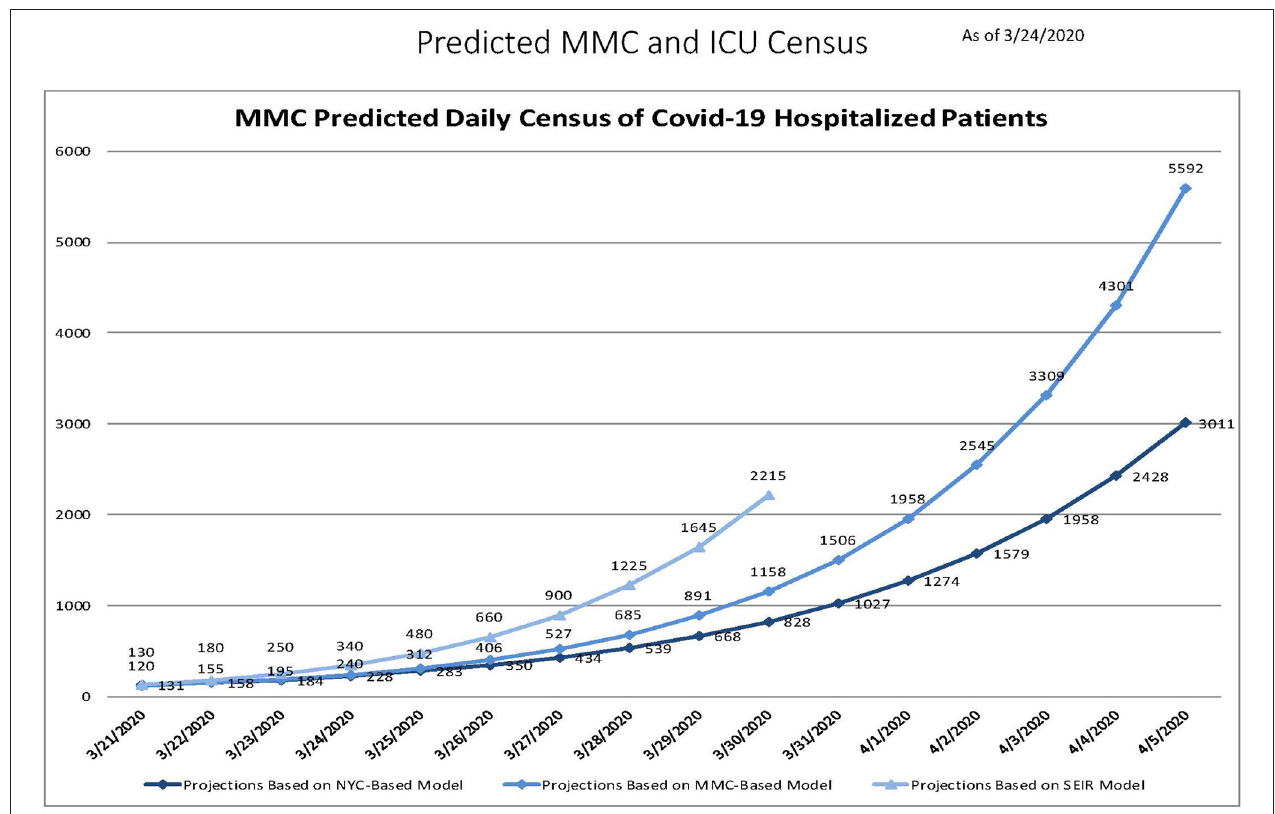
FIGURE 1 | Three predictive models generated on March 24, 2020 showing the expected exponential increase in daily Montefiore Medical Center census over the following 2